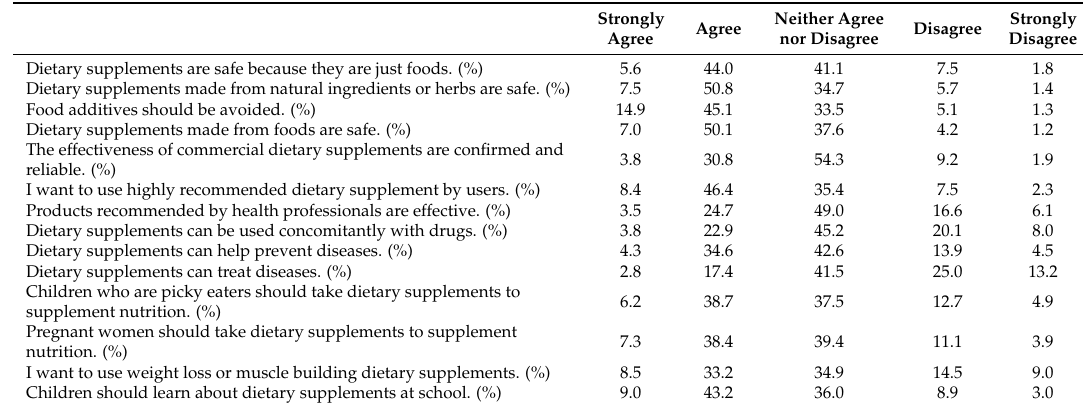
Table 9. Perceptions of dietary supplements among